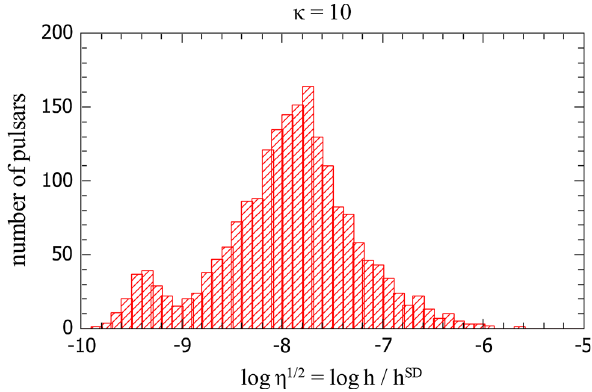
Fig. 5 Histogram of the efficiencies (or the spin-down ratio) for the 1964 pulsars of Table 1 for k = 10